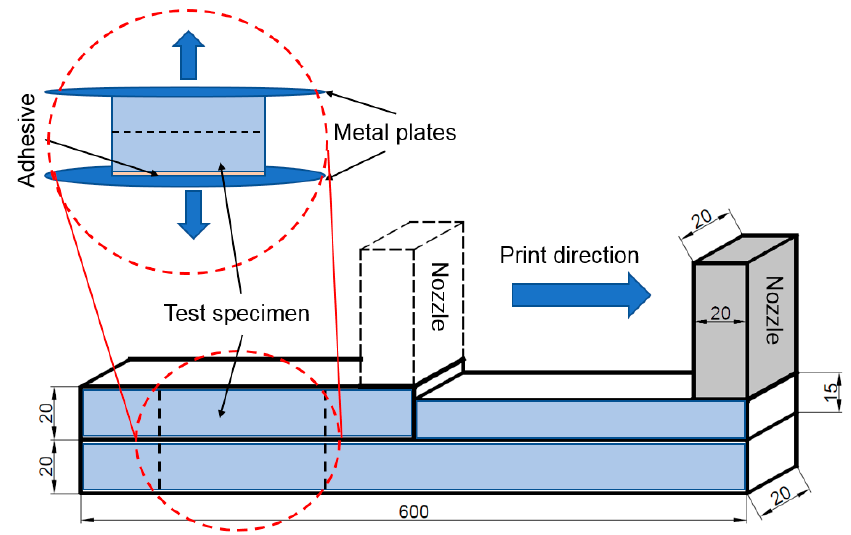
Figure 2. Schematic of sample preparation for tensile bond strength (dimensions are in mm).